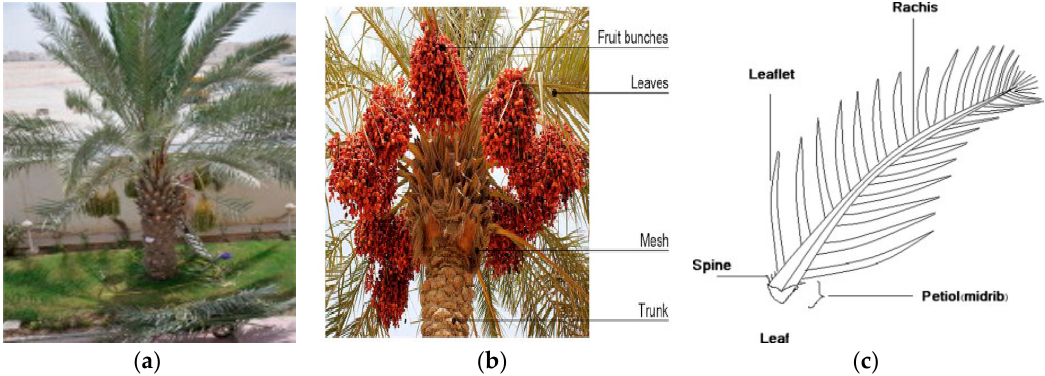
Figure 1. ( a – c ) Date pam tree [14]; ( a ) date palm tree components [15]; ( b ) and structural parts of date leaves [16] ( c ).